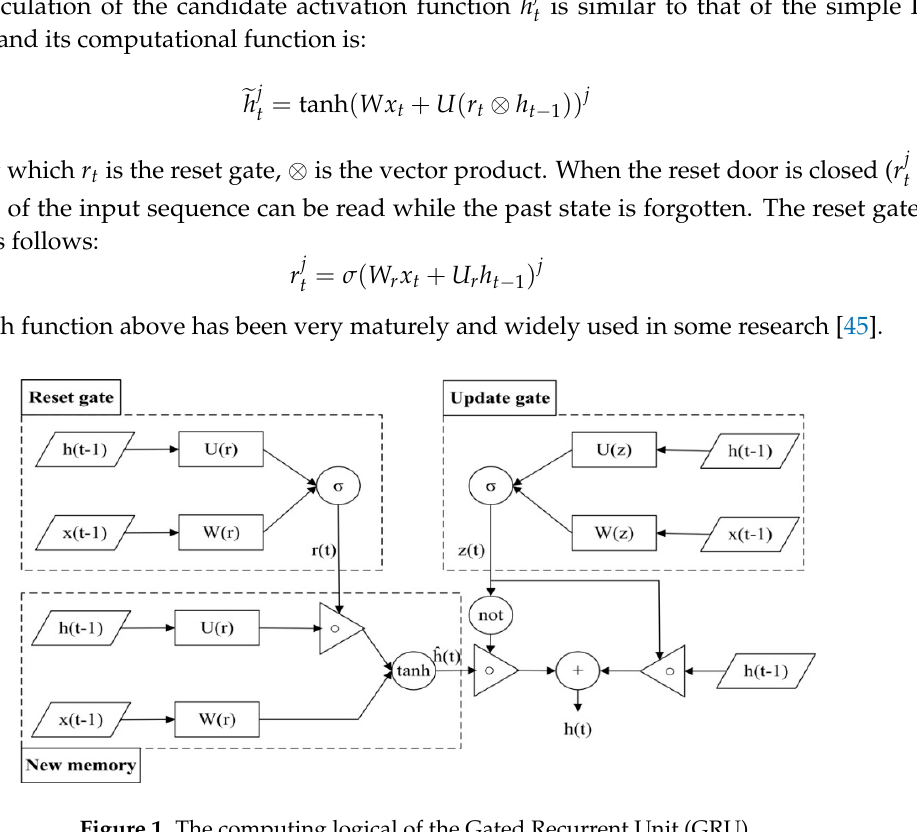
Figure 1. The computing logical of the Gated Recurrent Unit (GRU).